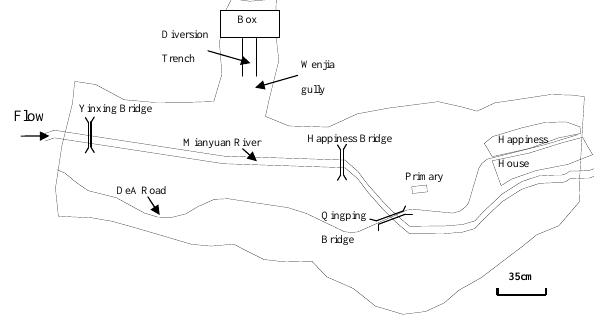
Figure 5. Sketch of model test Fig. 5. Sketch of model